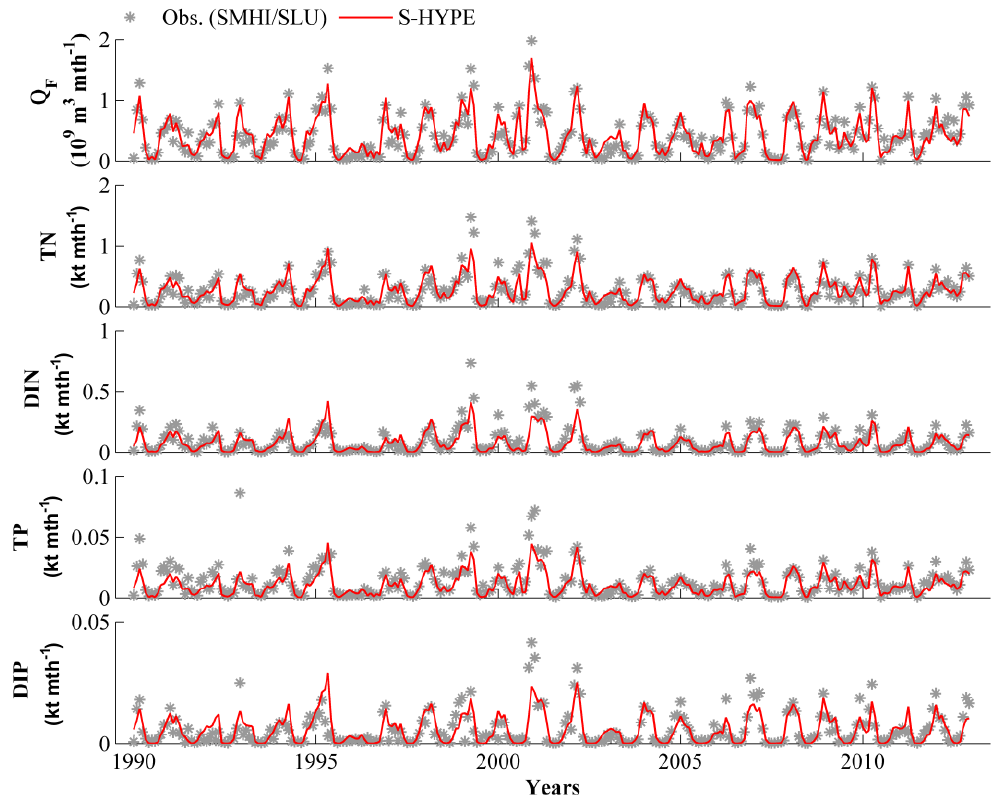
Fig. 5. Figure 5. Observed (asterisks) and modelled (line) monthly outflow ( Q F ) and nutrient loads from Lake Mälaren through Norrström to the Strömmen basin for the modelled period (1990–2012). DIN is the sum of nitrate and